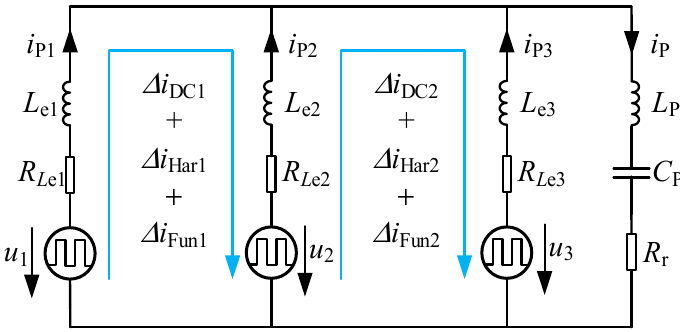
Figure 2. The equivalent circuit of the IPT system without the series-parallel resonant tank.